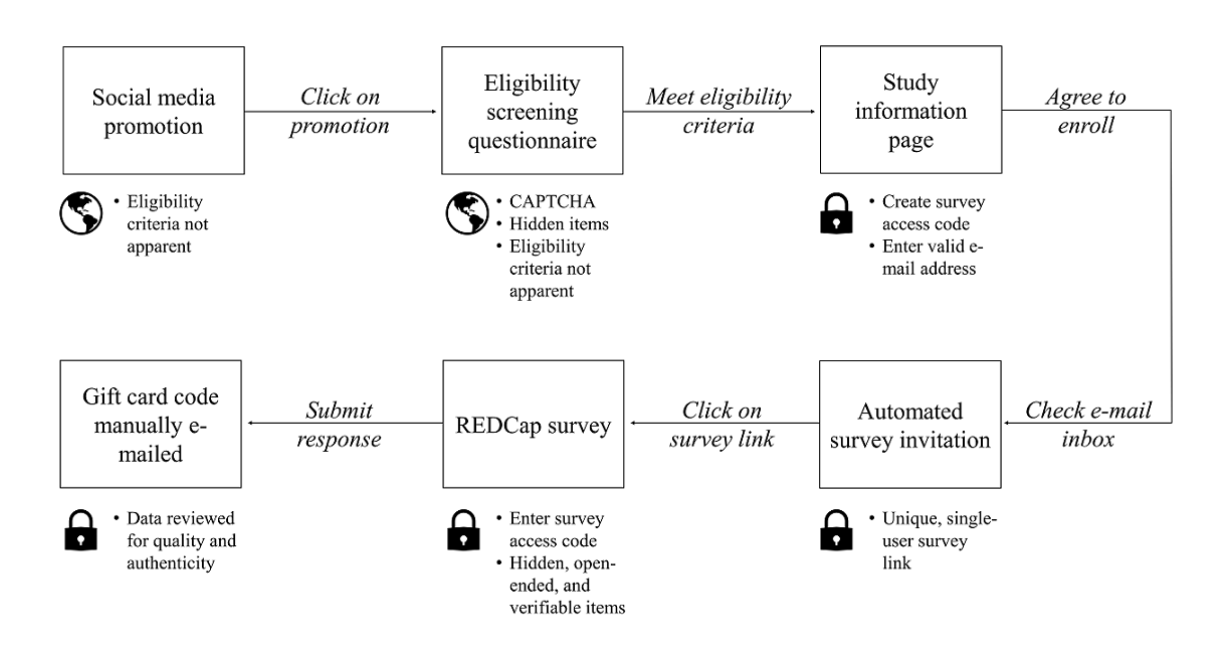
Figure 1. Procedure for participant recruitment and